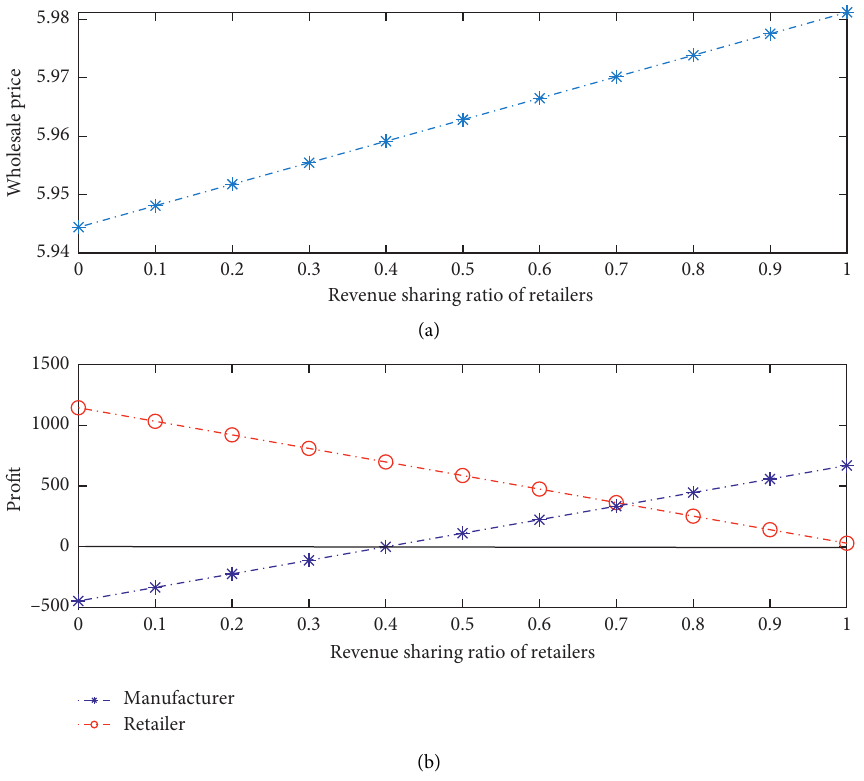
Figure 7: Wholesale price and profit under different revenue-sharing